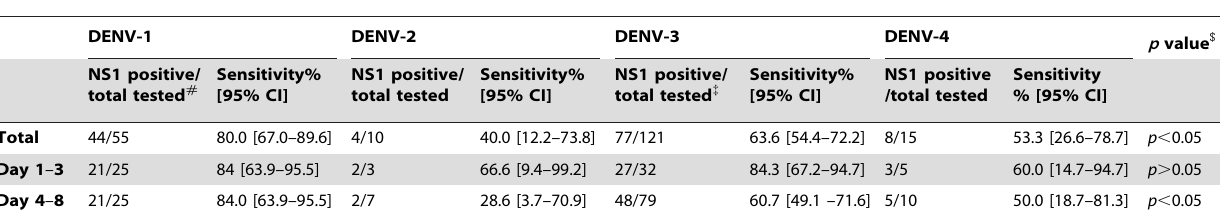
Table 4. Sensitivity of NS1 assay for each DENV serotype.